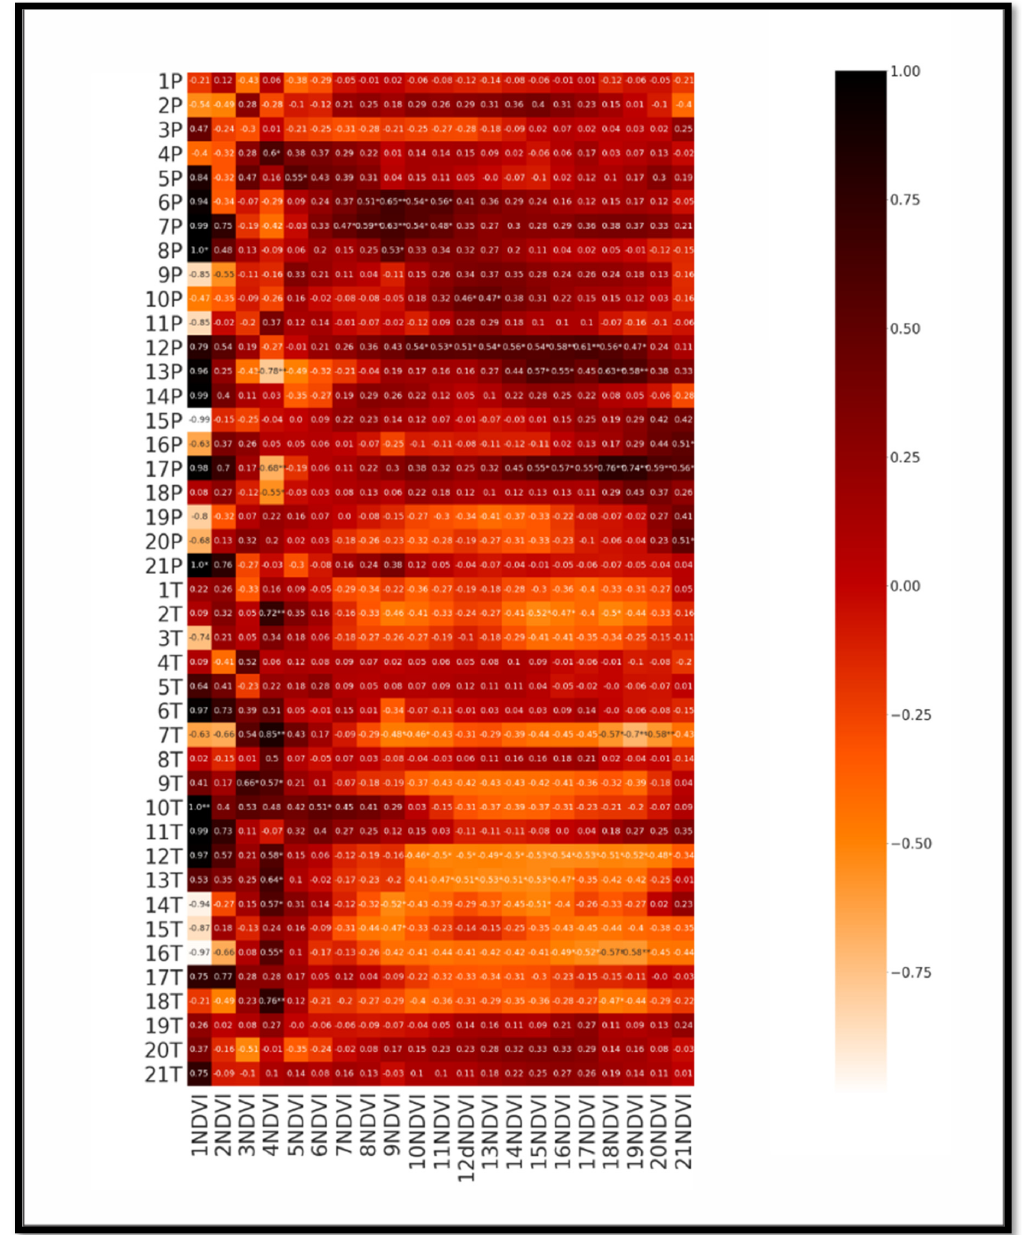
Figure 3. Correlation between 10-day values of temperature, precipitation and BRDF NDVI for Sisian, with the levels of significance: * − p < 0.05, ** p <